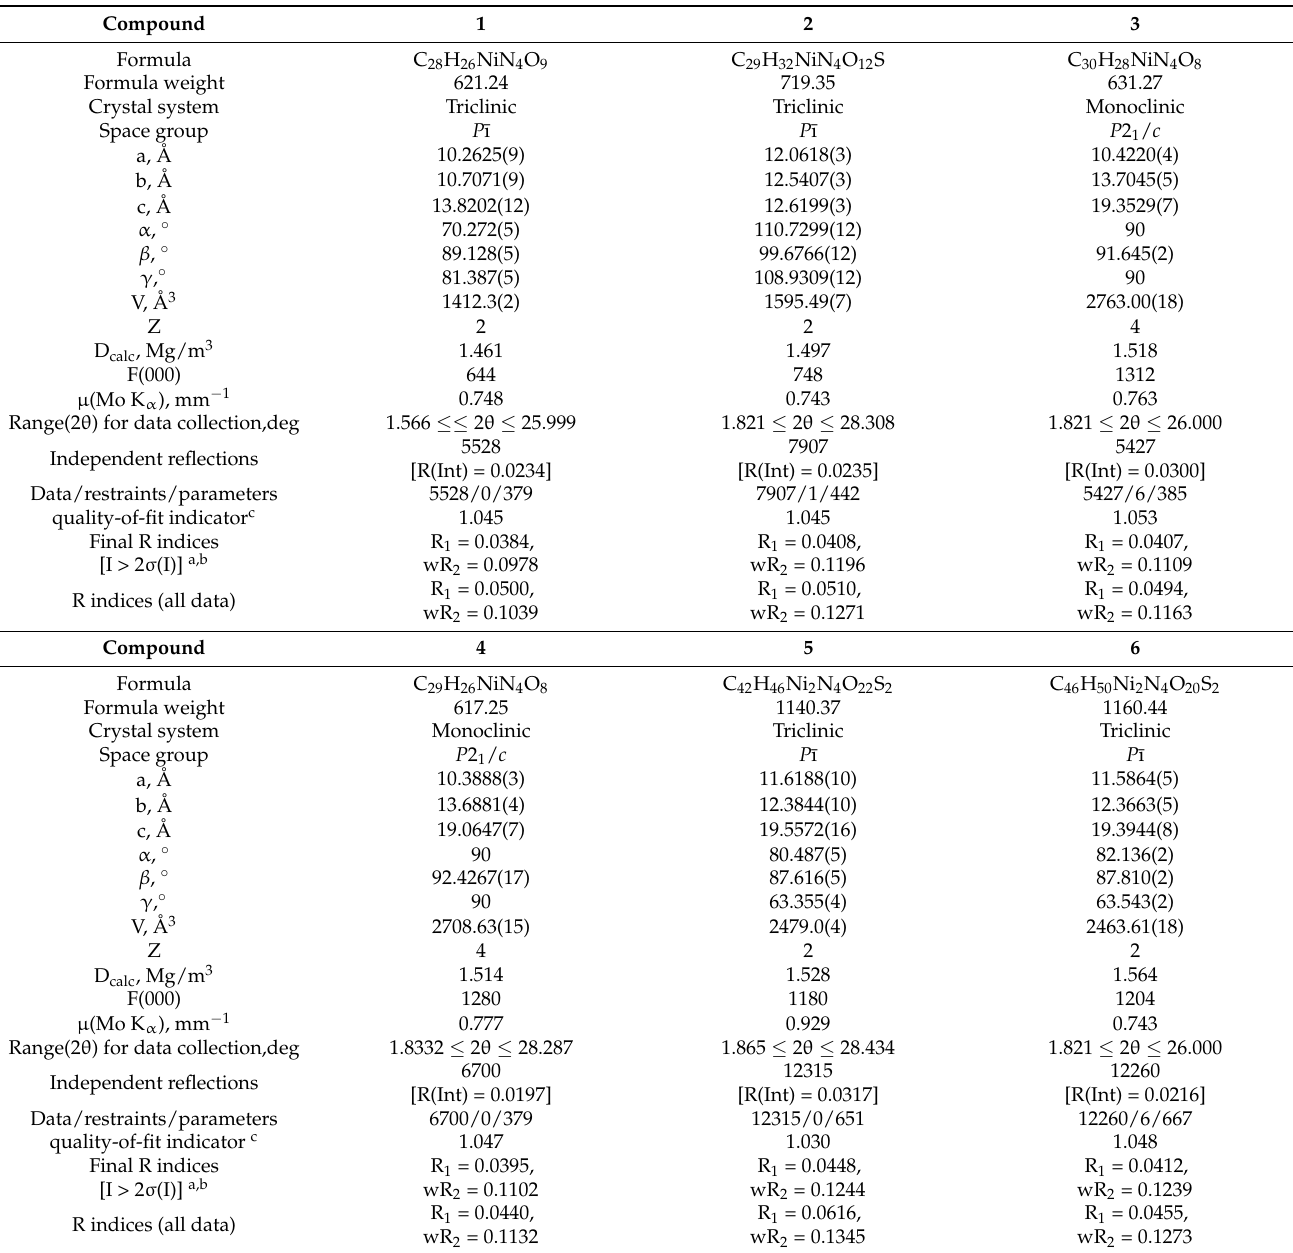
Table 5. Crystallographic data for 1 – 9